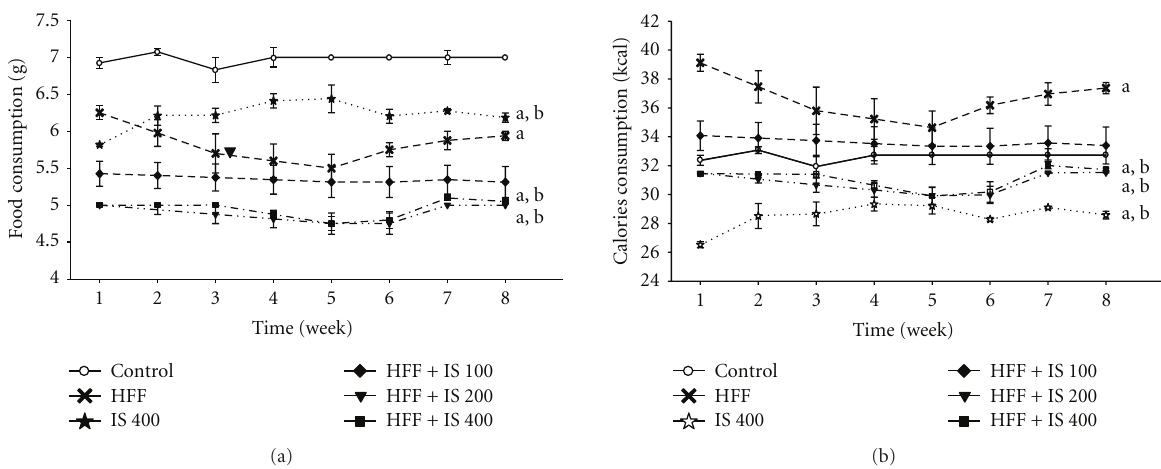
Figure 2: Food and calorie consumption (kcal) in mice fed a high-fat diet plus fructose (HFF) and treated with I. sonorae (IS) for 8 weeks; a: significant di ff erence compared to control; b: significant di ff erence compared to HFF, P < 0 . 05 (one-way ANOVA, Tukey’s post hoc test).